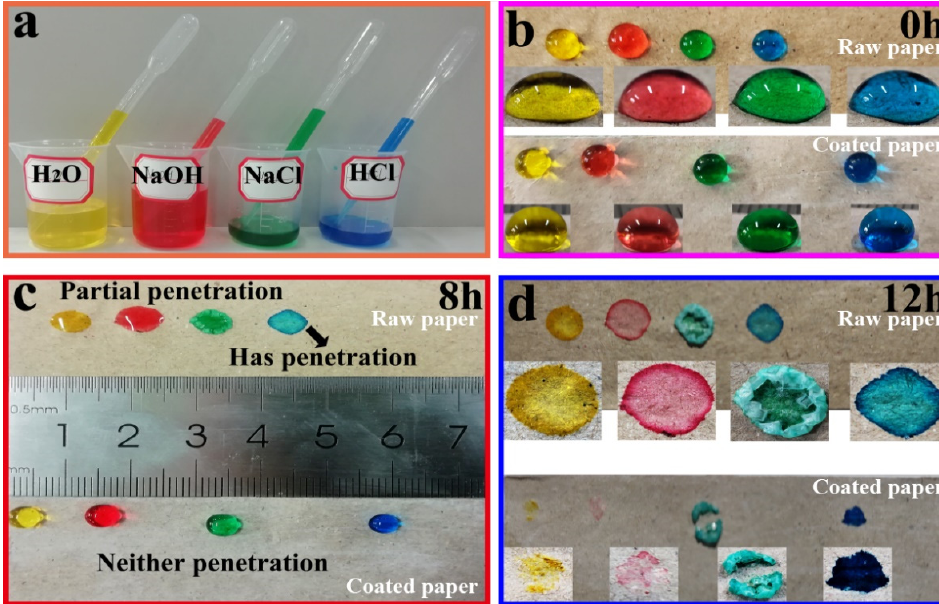
Figure 9. ( a ) Schematic diagram of acid, alkali, and salt, ( b ) Comparison diagram of 0 h corrosion resistance between base paper mulching film and coated paper mulching film, ( c ) Comparison diagram of 8 h corrosion resistance between base paper mulching film and coated paper mulching film, ( d ) Comparison diagram of 12 h corrosion resistance between base paper mulching film and coated paper mulching